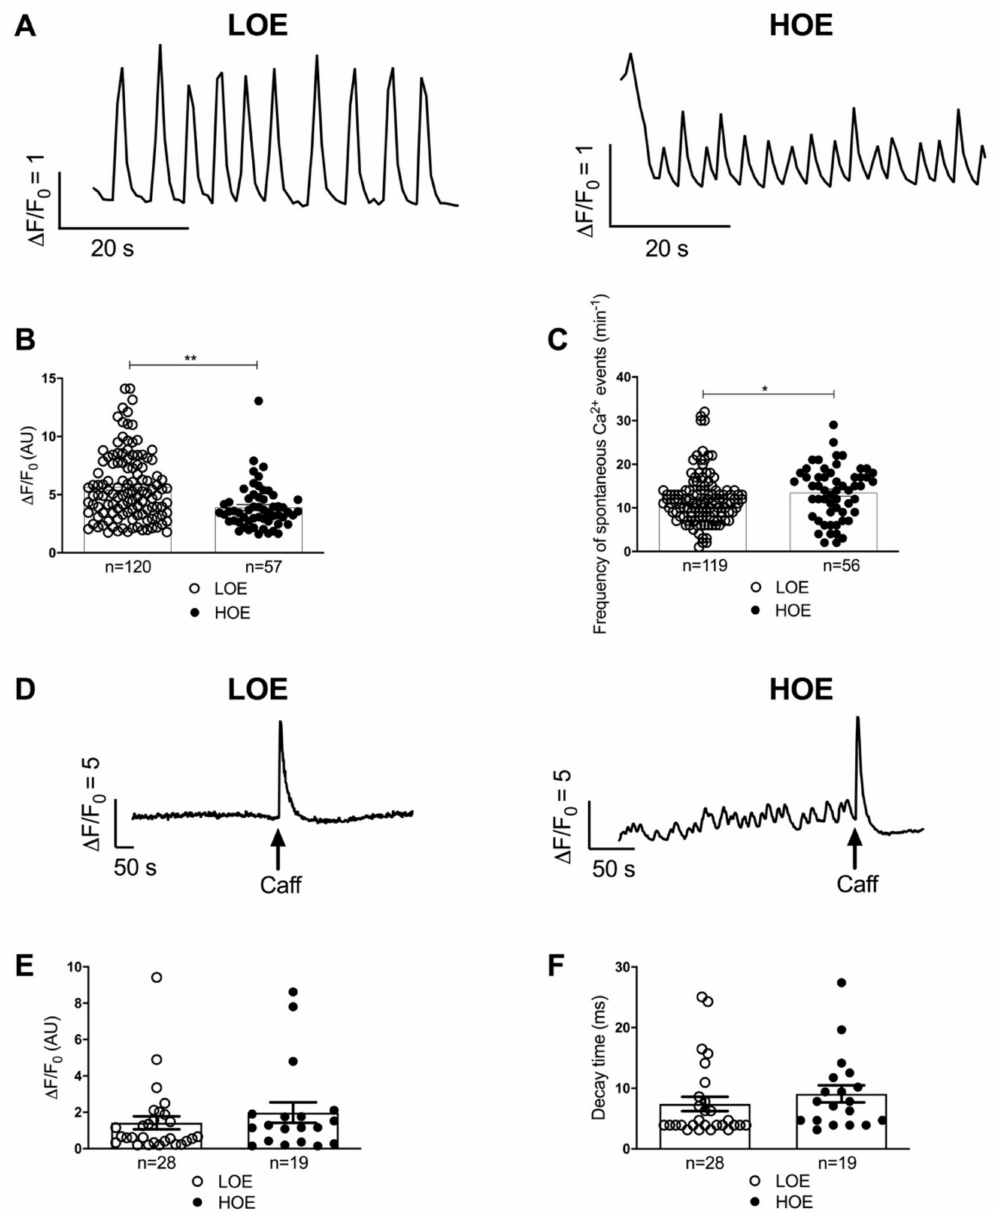
Figure 6. 3D cardiac spheroids differentiated under LOE exhibit more mature SR Ca 2+ handling. Intracellular Ca 2+ transients were measured in 25-day-old hPSC-CMs (using hiPSC UEFhfiPS1.4 and hESC CCTL12 lines) obtained from 3D cardiac spheroids in LOE (white bars) and HOE (black bars) conditions. ( A ) Display of original corresponding tracing line-scan images of Ca 2+ in hPSC-CMs differentiated in LOE and HOE conditions. ( B ) Normalized Ca 2+ -transient amplitude in hPSC- CMs differentiated in LOE and HOE conditions. ( C ) Frequency of spontaneous Ca 2+ events in hPSC-CMs differentiated in LOE and HOE conditions. ( D ) Representative traces of cytosolic Ca 2+ fluorescence in hPSC-CMs differentiated in LOE and HOE conditions upon 30 mM caffeine (Caff). ( E ) Amplitude of SR Ca 2+ load in hPSC-CMs differentiated in LOE and HOE conditions. ( F ) Decay phase of the SR Ca 2+ load in hPSC-CMs differentiated in LOE and HOE conditions. The number of cells evaluated varies from 19 to 120 cells for each dot plot from 3 independent biological replicates. Data are shown as mean ± SEM. Significance was calculated by Mann-Whitney test. *, p < 0.05, **, p <